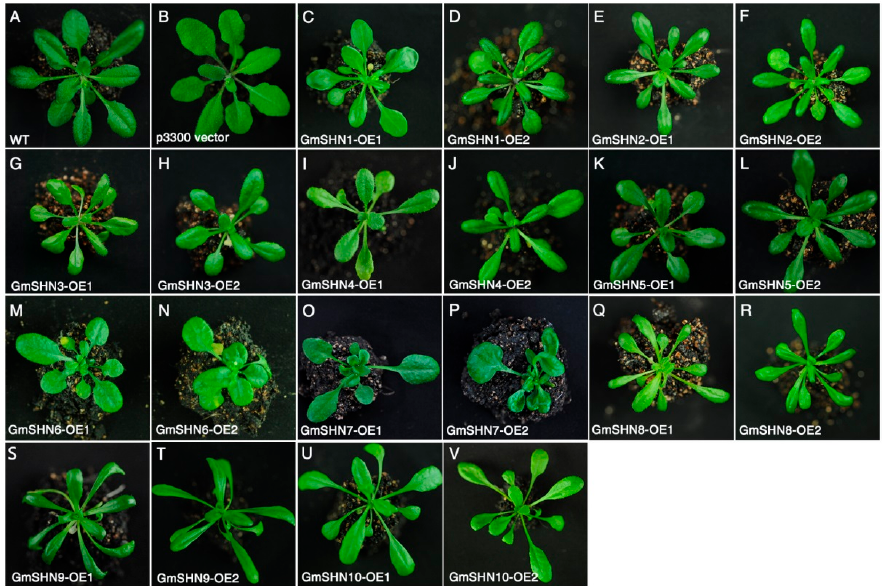
Figure 4. The constitutive expression of GmSHN genes in Arabidopsis plants. WT ( A ) and a transgenic line overexpressing the p3300 empty vector ( B ) were used as negative controls. Transgenic lines overexpressing each of the GmSHN genes ( C – V ) showed differences in leaf phenotypes. Pictures were taken at the same magnification and all the plants were at the period of four weeks old.